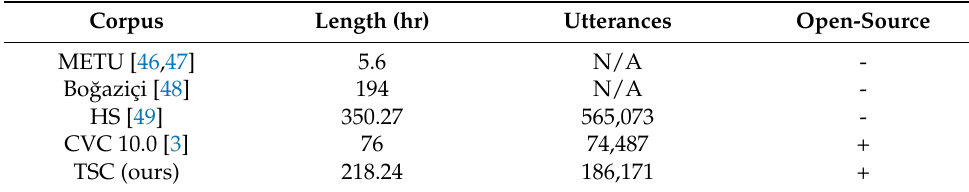
Table 2. Turkish ASR